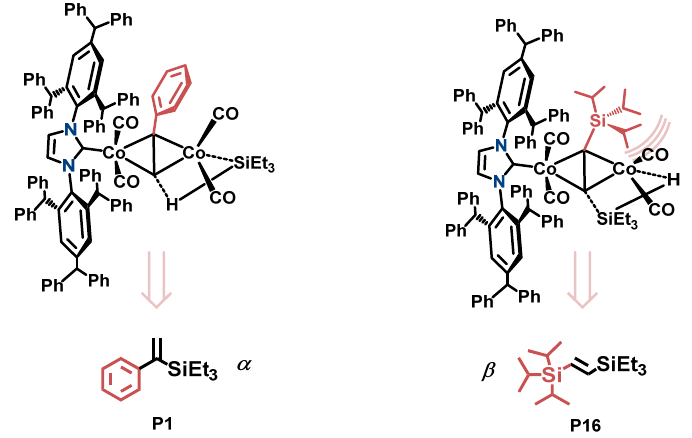
Figure 3. Influence of substrate’s steric nature on reaction selectivity.